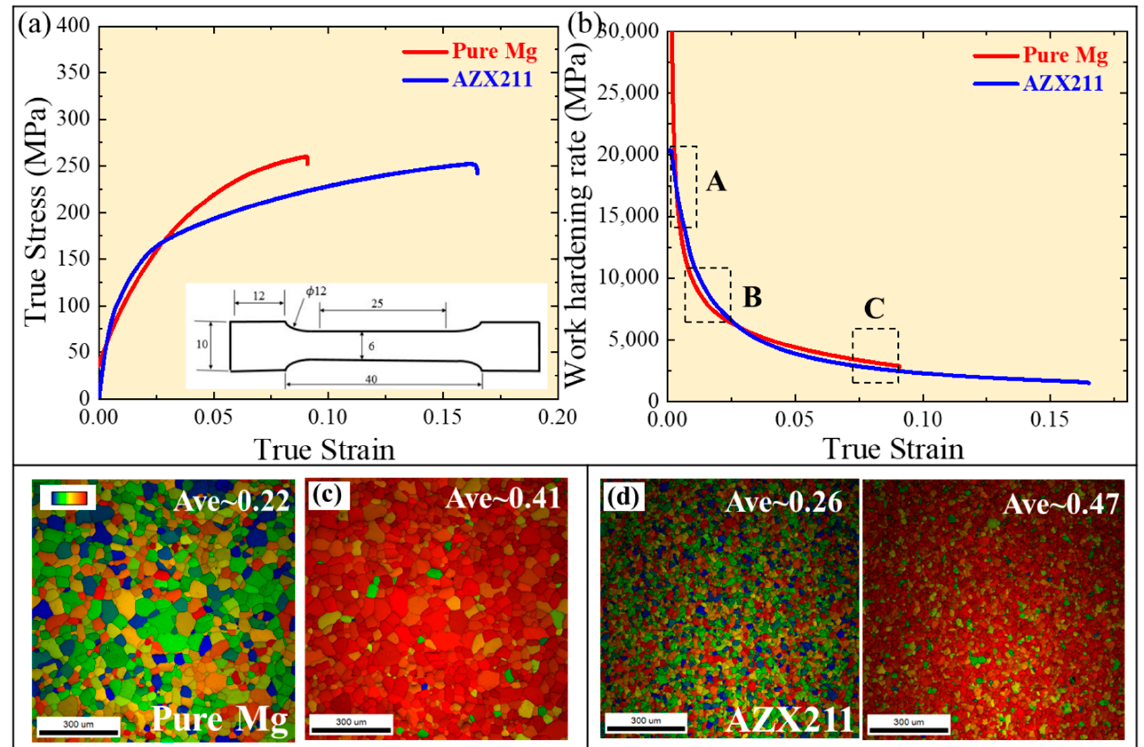
Figure 7. ( a ) True stress–strain curves (Inset is tensile sample dimensions) and ( b ) strain-hardening curves for pure Mg and AZX211, Schmid factor of basal and non-basal slip systems of ( c ) pure Mg and ( d ) AZX211.